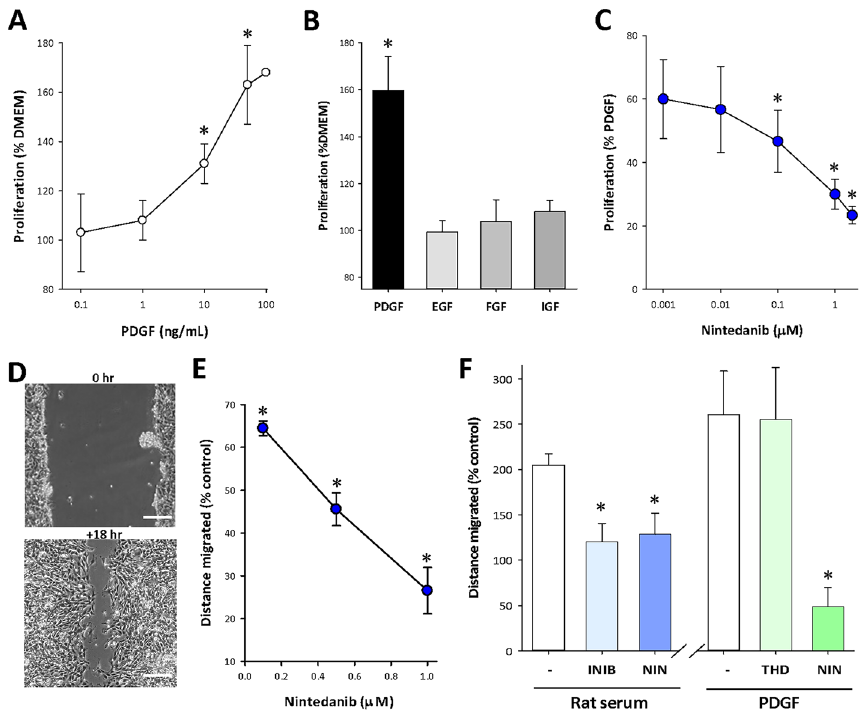
Figure 2. NIN inhibits a PDGF-induced growth and migration of CSMC. ( A ) Concentration-dependent growth of CSMC in response to the mesenchymal growth factor PDGF-BB. *p < 0.05 vs untreated control; n = 5 cell lines in triplicate assay. ( B ) Absence of growth response of CSMC to growth factors EGF, FGF or IGF compared to PDGF-BB (48 h, all 50 ng/mL). *p < 0.05, n = 3 cell lines in triplicate assay. ( C ) Inhibition of PDGF-BB stimulated CSMC growth by nintedanib. *p < 0.05, n = 3 cell lines in triplicate assay. ( D ) Representative images of scrape-wounding assay of cell migration in vitro. Top, appearance after wounding. Bottom, at + 18 h showing cell migration. Scale bar, 125 µm. ( E ) Quantitative analysis of nintedanib-induced inhibition of FCS-stimulated cell migration. *p < 0.05 vs serum control; n = 3 cell lines in triplicate. ( F ) Nintedanib (NIN) blocked PDGDF-induced CSMC migration independently of cell proliferation. Left, inhibition of rat serum-stimulated migration by the PDGF-receptor blocker Imatinib (2 µM) or NIN (1 µM). Right, PDGF-induced CSMC migration was not affected by mitotic inhibition with thymidine (THD, 2 mM) but was blocked by NIN (1 µM). *p < 0.05 vs untreated control; n = 3 cell lines in triplicate